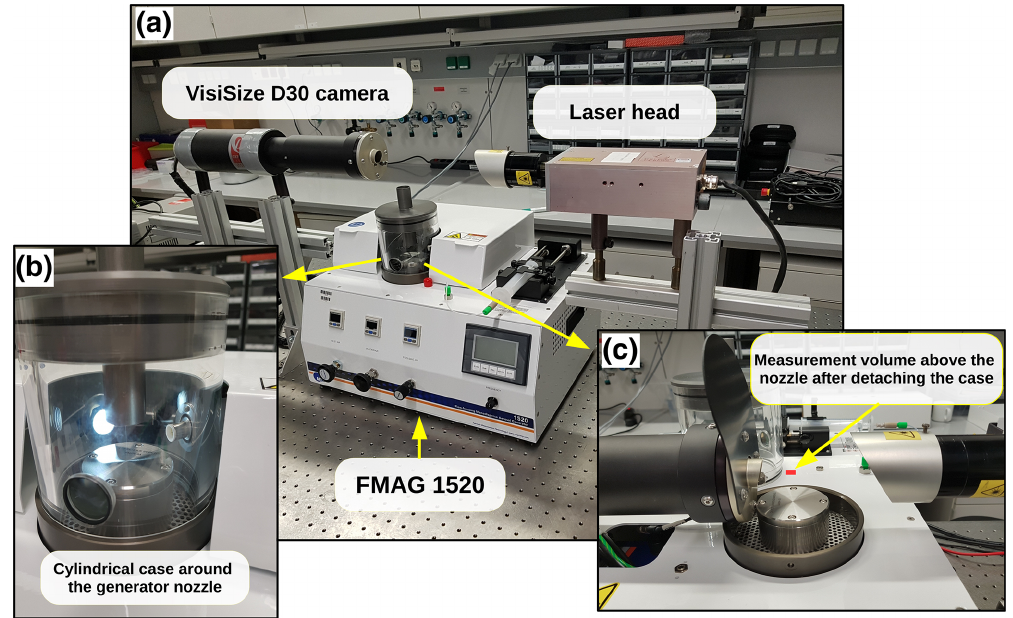
Figure 10. Experimental setup for studying sizing performance. The VisiSize D30 was located above the exit of the FMAG in order to measure outgoing droplets (a) in the configuration with the cylindrical case above the nozzle (b) and in the configuration without the case (c) .